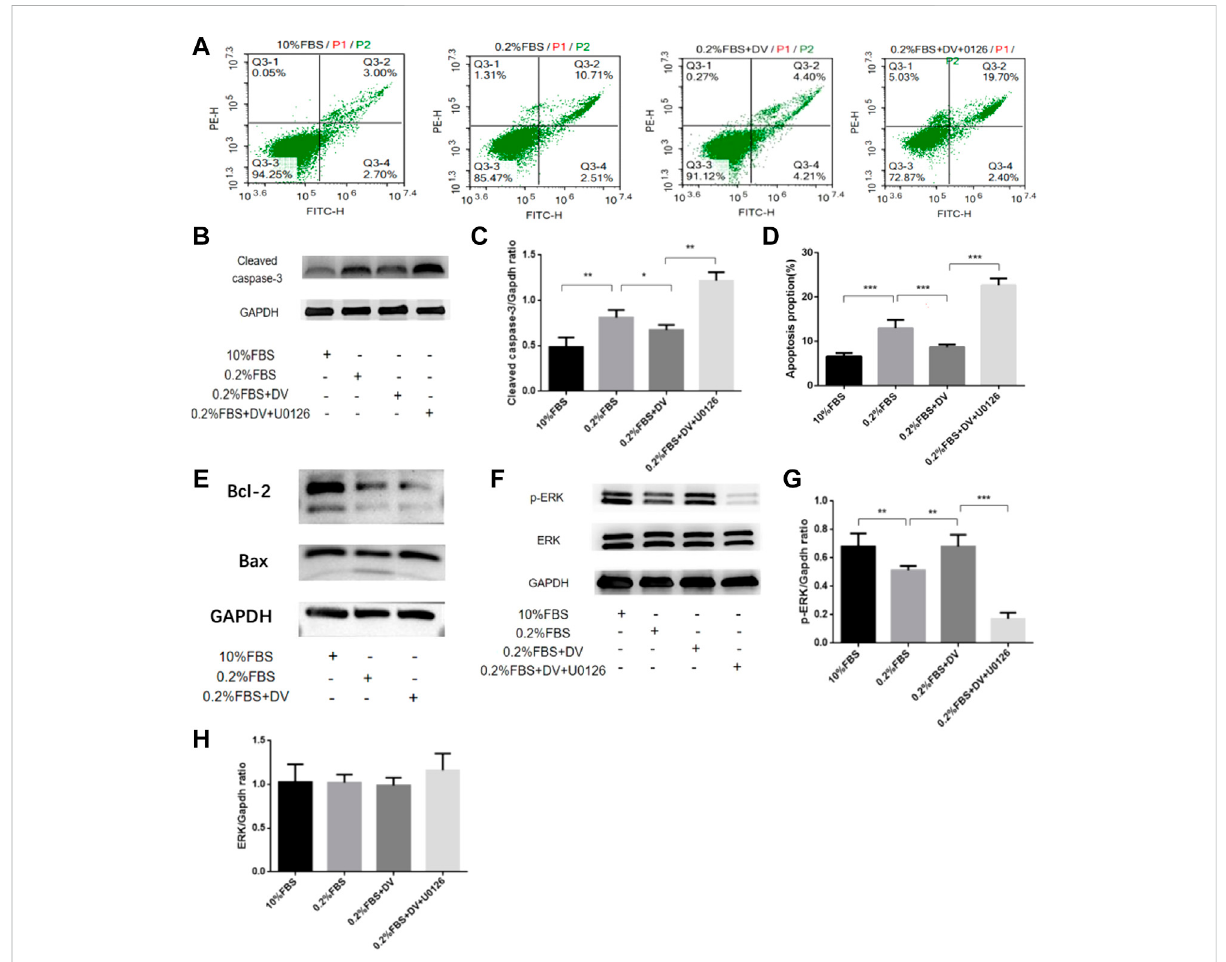
FIGURE 3 Endorepellin protects from apoptosis in the ureteric bud via the ERK1/2 pathway. (A) Annexin-V PE/FITC-stained apoptotic cells induced by serum deprivation and rescued byendorepellin inMk3cells. (B) Anti-cleaved caspase-3 westernblotanalysisofMK3cellsas labeled, with GAPDHas the internal loading control. (C) Densitometry analysis of cleaved caspase-3 western blot as shown in B as normalized to the corresponding GAPDH bands( n =3). (D) Apoptosisratiosareshowninthediagram.PercentageofmK3 cellsstainedwithAnnexin-VPE/FITC after exposurefor24 hto